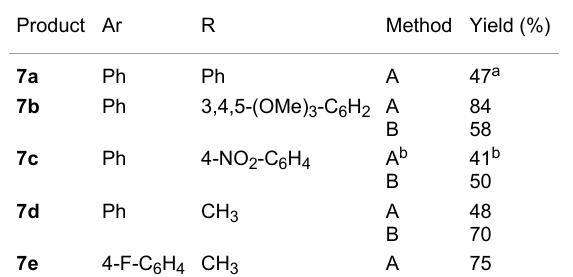
Table 1: 1,2,4-Triazolium-3-aminides 7 synthesized (see Scheme